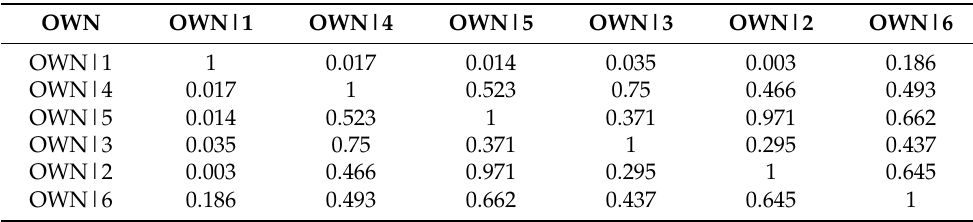
Table 8. p -Values between ownership and extent of the ethical code after Bonferroni-corrected significance level: